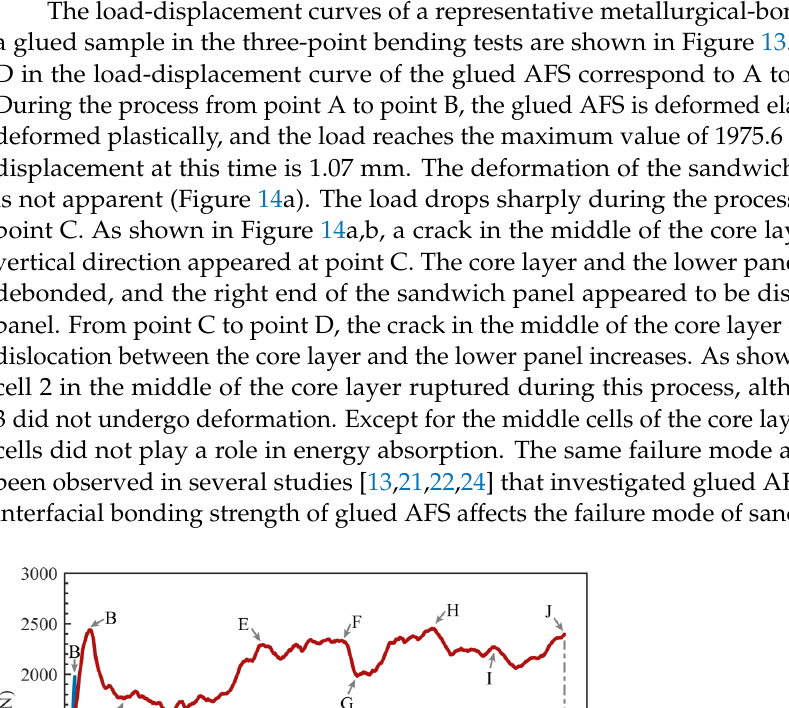
Figure 12. Macroscopic morphology of fracture area of metallurgical bonded AFS after stretching.